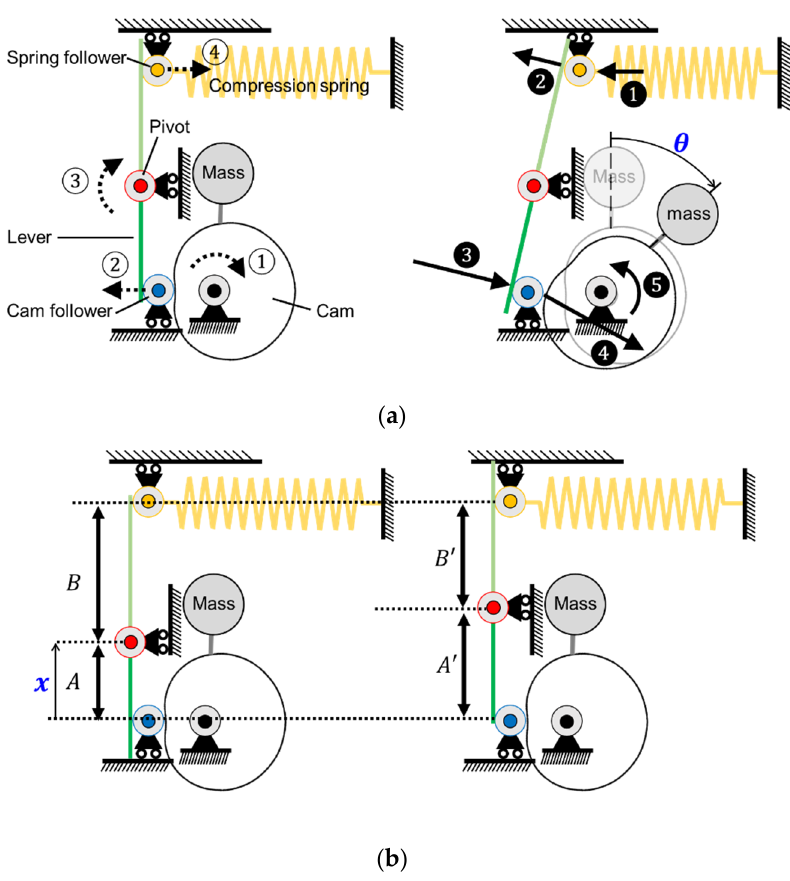
Figure 3. Operating concepts of CVGC for compensating a gravitational torque by mass: ( a ) Configuration and motions of CVGC. The white circled digits indicate the orders of motions describing the spring deformation due to the cam rotation. The black circled digits represent the order of forces that account for the compensating torque in the cam generated by the spring force. 𝜃 is the rotation angle of the cam; ( b ) principle of torque variation. The movement of the pivot can change the amplification ratio (B/A or B’/A’). B/A is larger than B’/A’, so it generates a larger compensation torque at the cam axis , and 𝑥 denotes the distance between pivot position and cam follower.